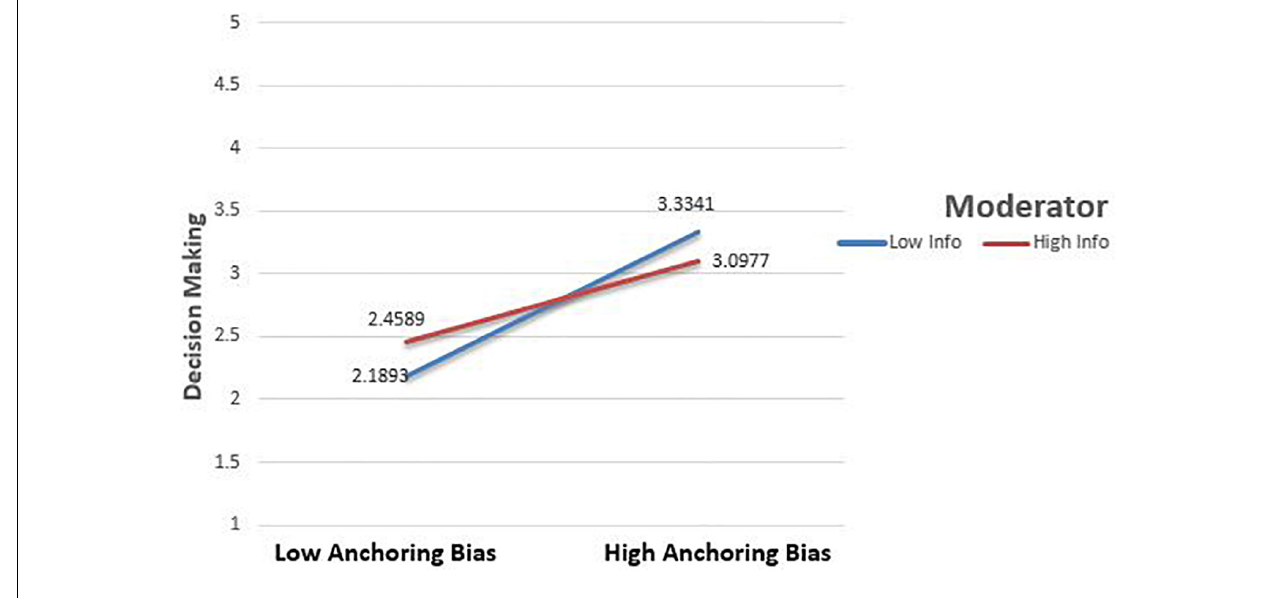
FIGURE 2 | Interaction effect between Anchoring and Decision Making.